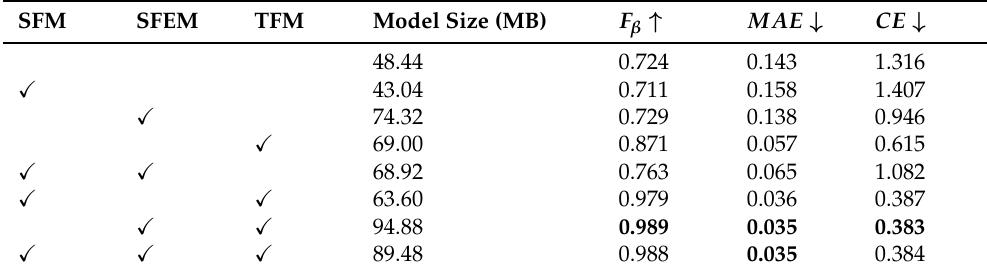
Figure 8. Saliency detection results of SDebrisNet without different components: all of the frames are collapsed by a max operator. Table 6. The ablation study of SDebrisNet on the SDD dataset.